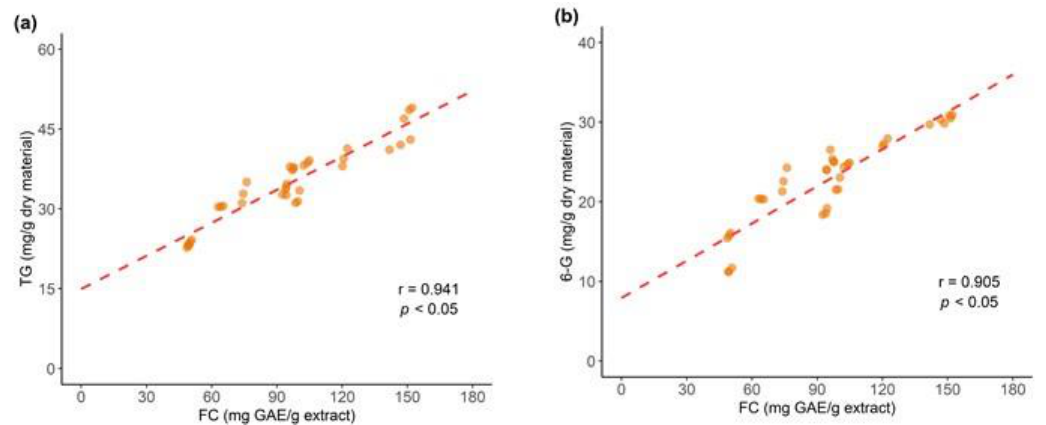
Figure 12. Correlation of total polyphenolic (TP) contents and UPLC-DAD results on ( a ) total gingerol (TG) ( b ) 6-gingerol contents.